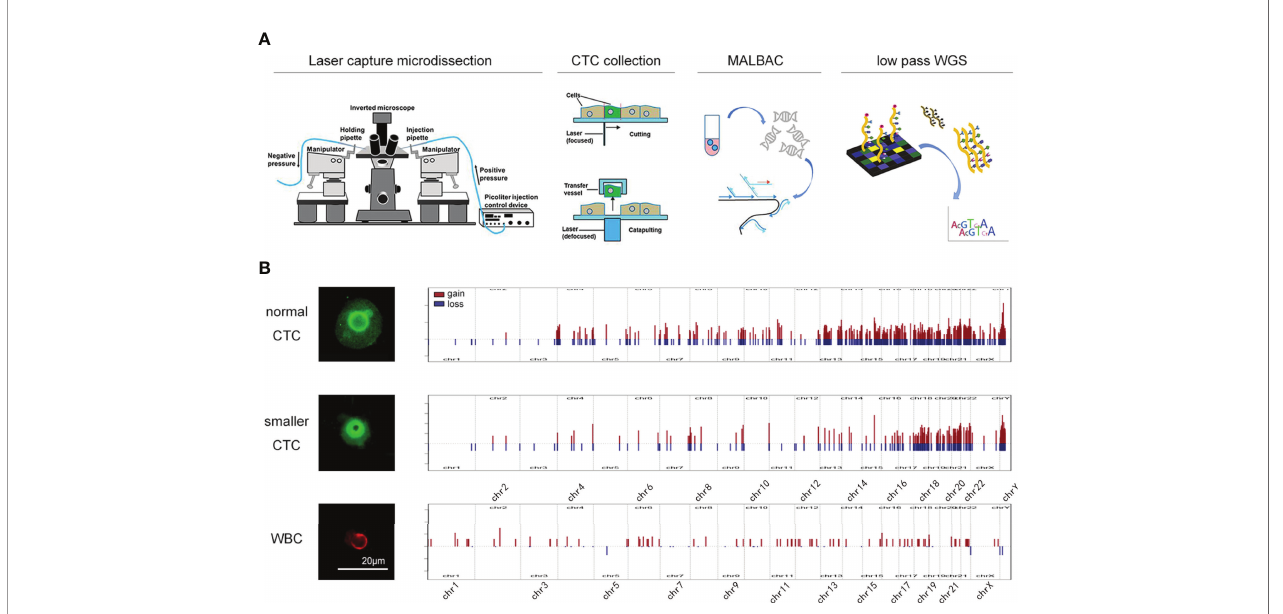
FIGURE 1 | The isolation and sequencing of glioma CTC. (A) Schematic of the experimental design. CTCs were collected by LCM technology and ampli fi cation was performed by MALBAC technology. The ampli fi ed products were used to perform DNA-seq. (B) The CNV pattern in normal CTC (upper), smaller CTC (middle), and leukocytes